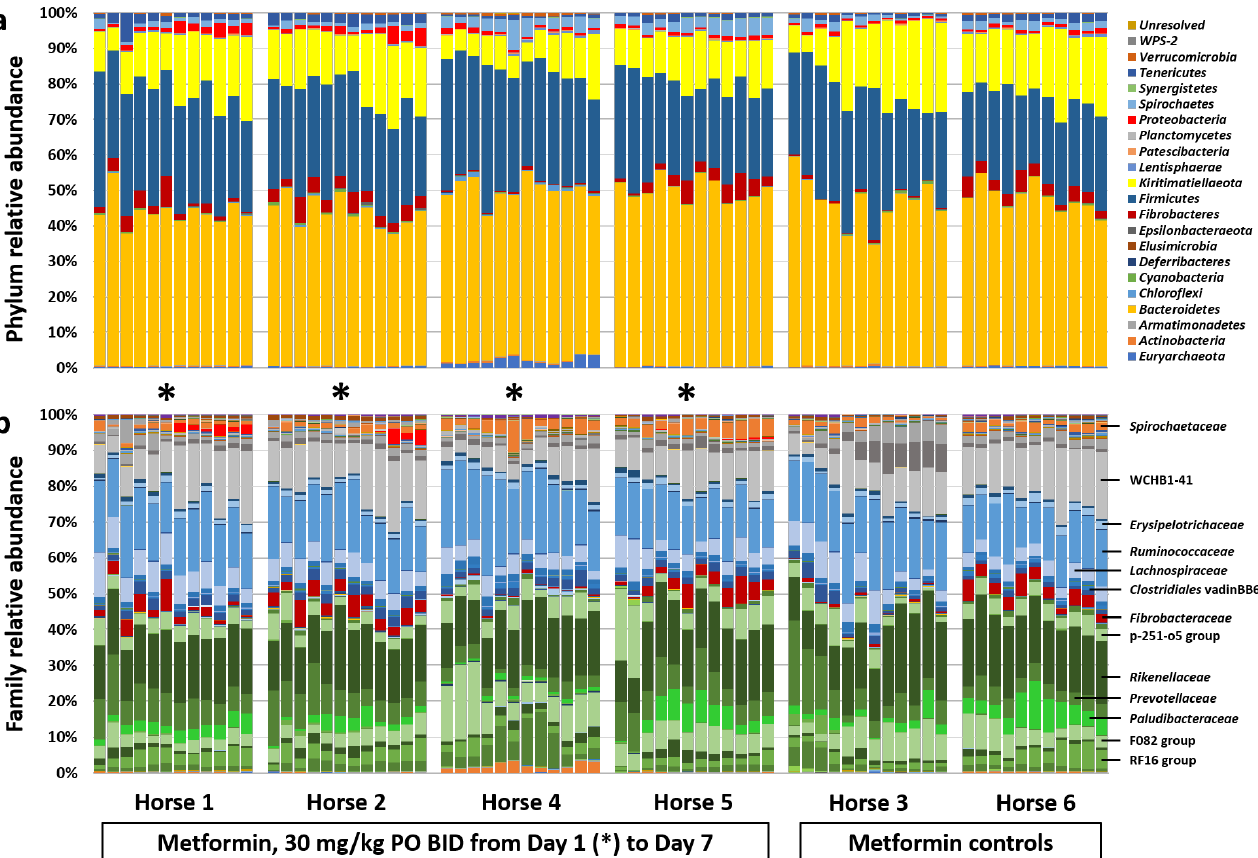
Figure 3. Changes in relative abundance of dominant taxa over time following diet change. Stacked bar chart showing the relative abundance of bacterial DNA detected in the feces of horses switched to an all-hay diet ( n = 6), at the taxonomic level of phylum ( a ) and family ( b ). Samples for each horse are shown in chronological order, and the initiation of metformin treatment is denoted by an asterisk. Legend for dominant taxa shown at right.